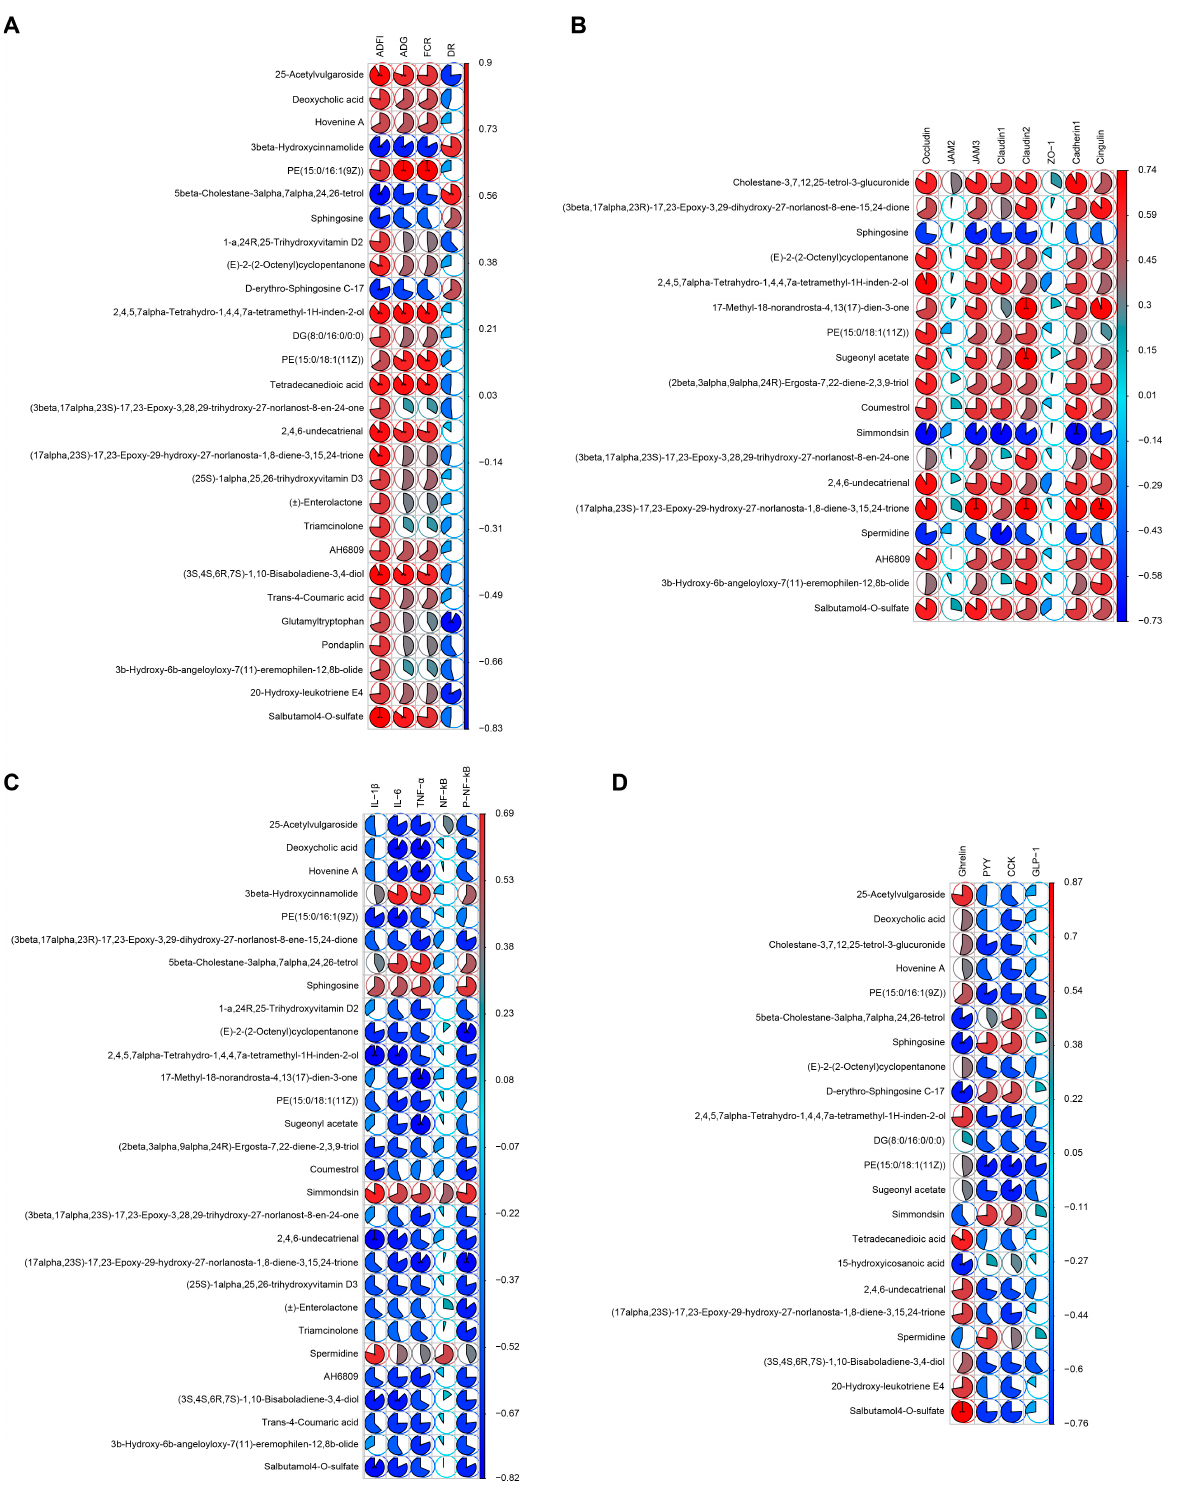
Figure 6. Correlation analysis of the ileal metabolome with growth status, intestinal epithelial barrier, inflammatory response and plasma hormone levels in weanling rabbits. ( A ) Ileum metabolome and growth status of weanling rabbits. ( B ) Ileal metabolome and intestinal epithelial barrier-related genes in weanling rabbits. ( C ) Ileal metabolome and intestinal inflammatory factors. ( D ) Ileal metabolome and gut–brain hormones in the intestine. *: 0.01 < p ≤ 0.05, **: 0.001 < p ≤